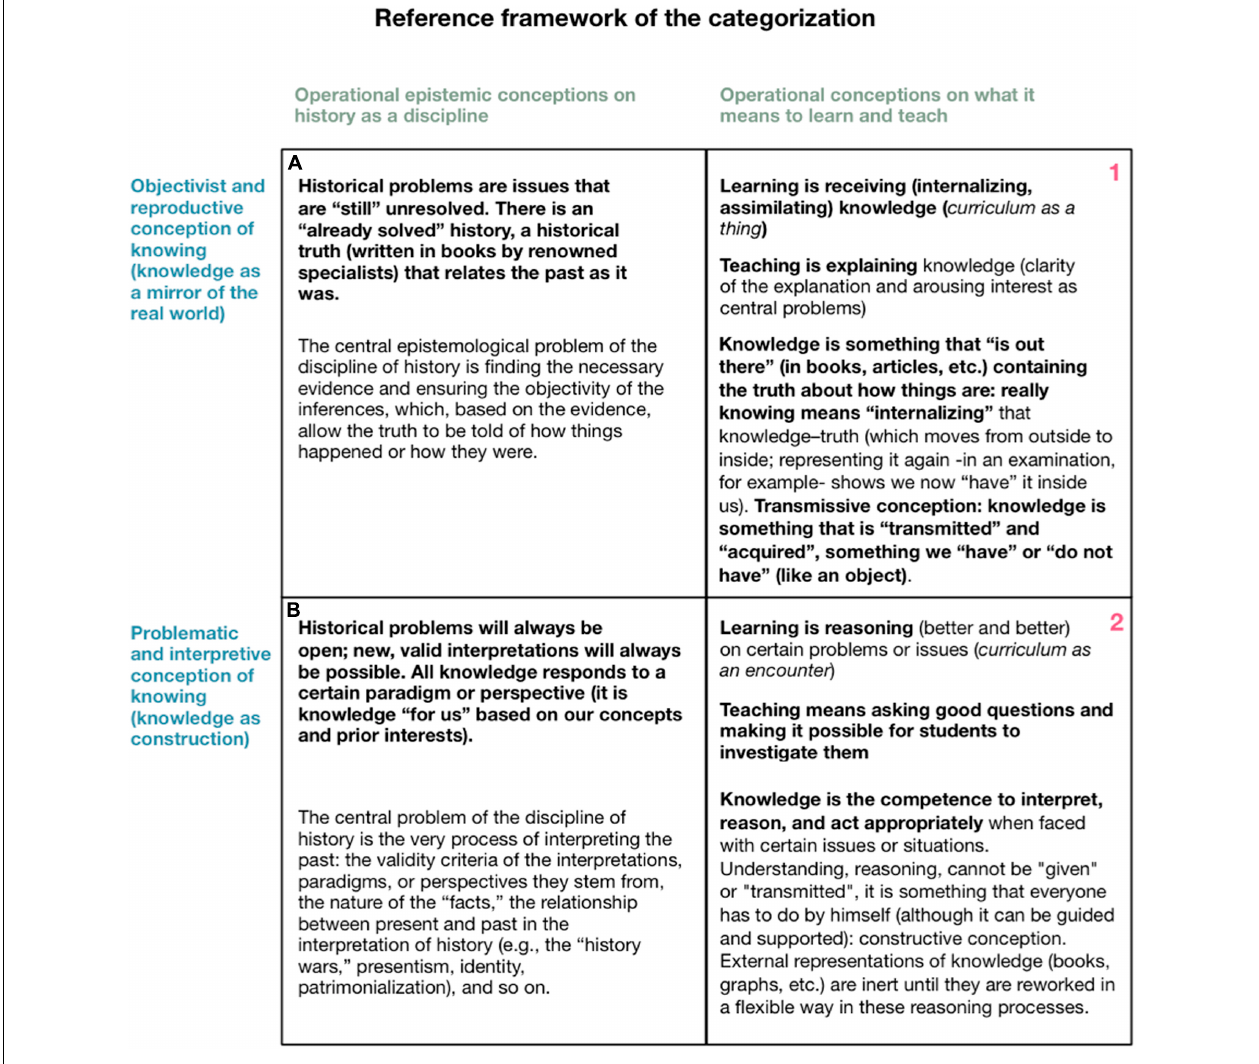
FIGURE 2 | Cross-reference framework of epistemic conceptions of history ( A : “history as the past” and B : “history as an interpretation”) and conceptions of teaching and learning ( 1 : “teaching as transmission of contents and learning as reproduction” and 2 : “teaching as facilitating conceptual change and learning as